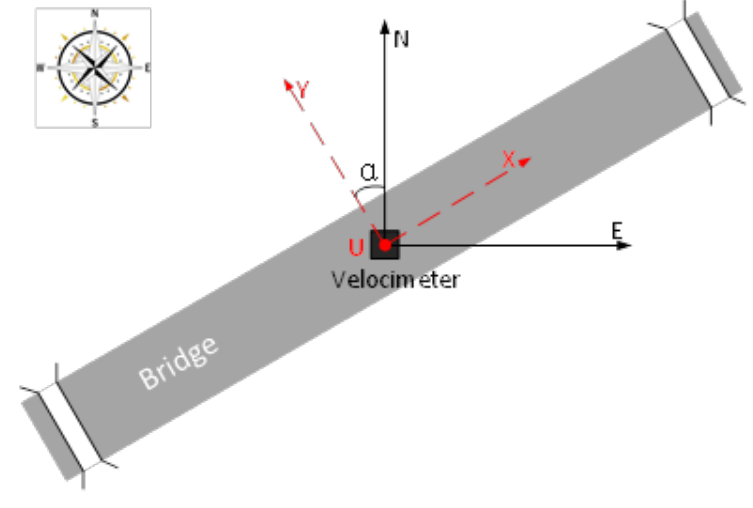
Figure 1. Equipment installation diagram on the bridge.